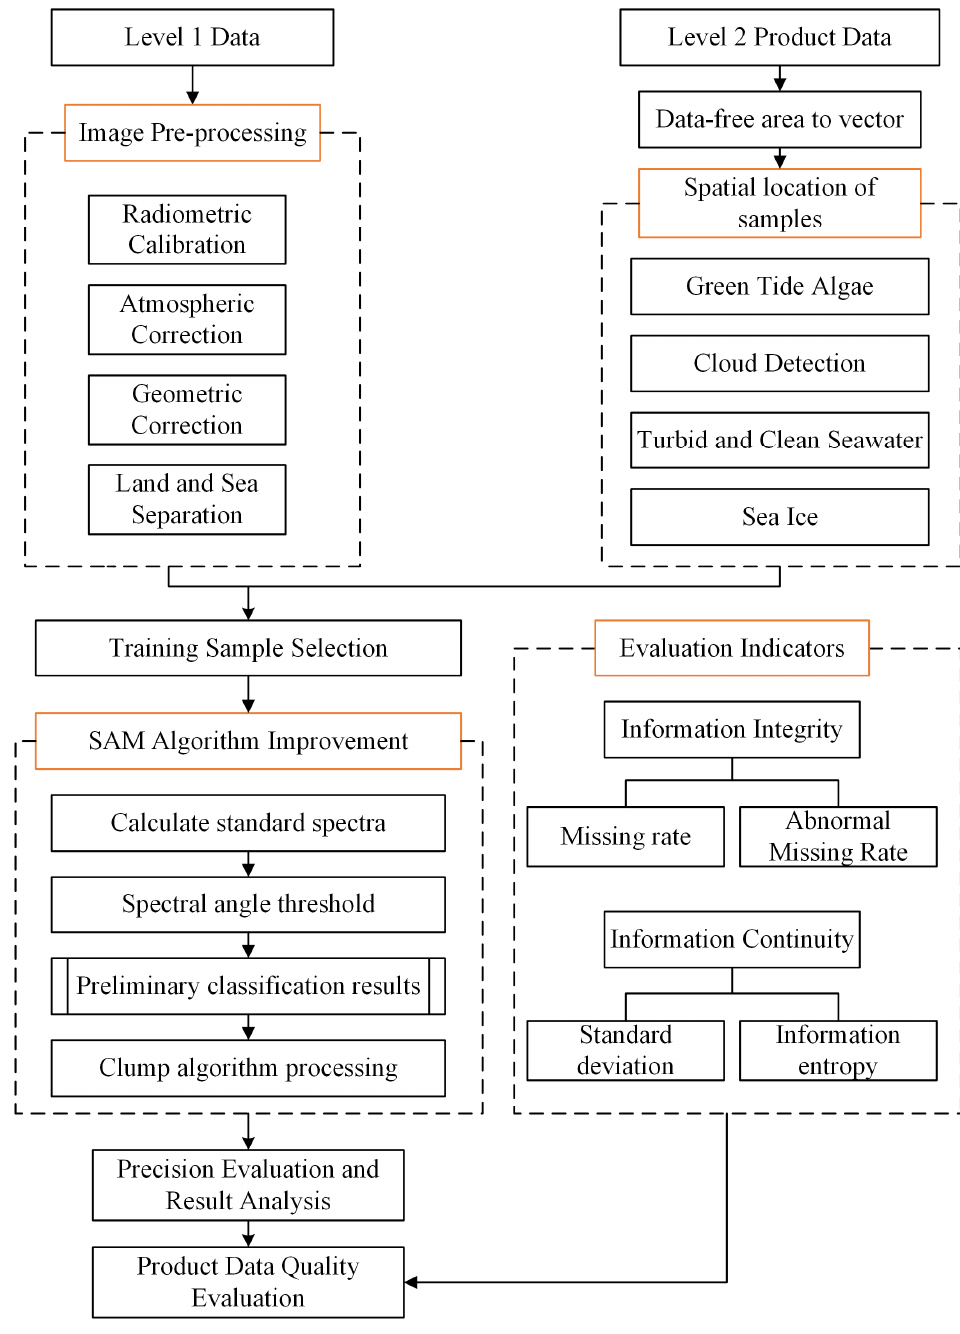
Figure 2. Framework and technical methods.